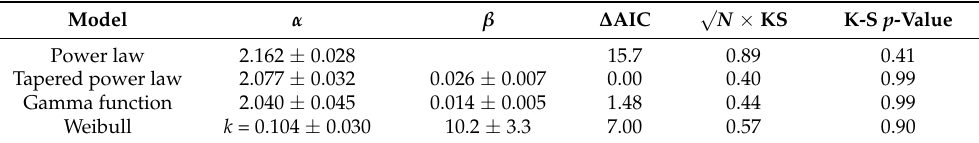
Table 2. Derived parameters for X-ray peak flux distributions ( F 0p = 3 × 10 − 5 W m − 2 , N = 1720). See text for details.